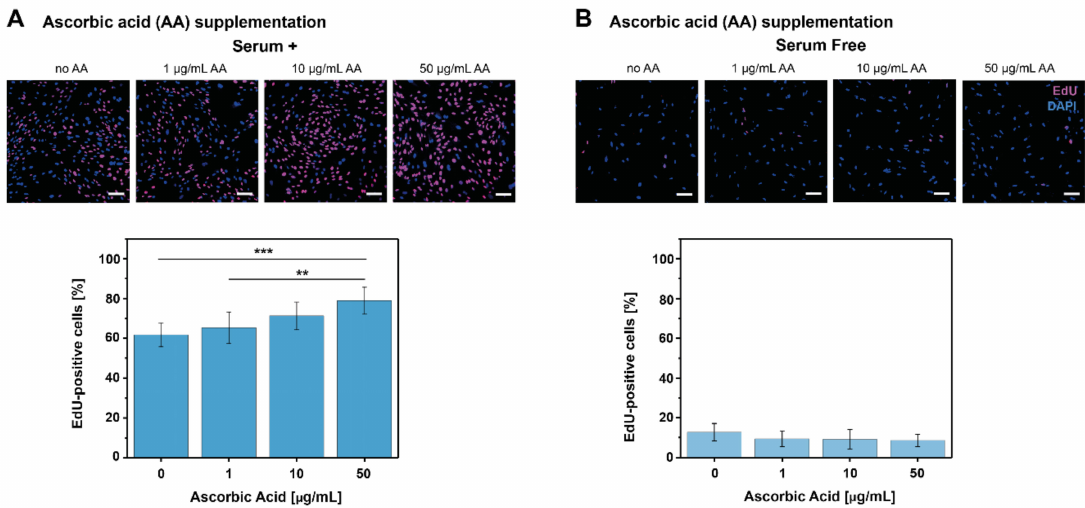
Figure 1. E ff ect of AA on tenocyte proliferation. Representative CLSM images from the EdU proliferation assay and EdU-positive cells [%] for each AA concentration ( µ g / mL) tested in ( A ) serum + conditions and ( B ) serum-free conditions. The e ff ect of di ff erent PDGF-BB concentrations on tenocyte proliferation assessed by the EdU assay is presented in Figure S1. The total EdU-positive cells [%] was calculated as EdU positive cells (pink) in relation to the total cell number (DAPI stained, blue). Scale bars: 100 µ m. (Data is shown as mean ± standard deviation, ** p < 0.01, *** p < 0.001 obtained by one-way